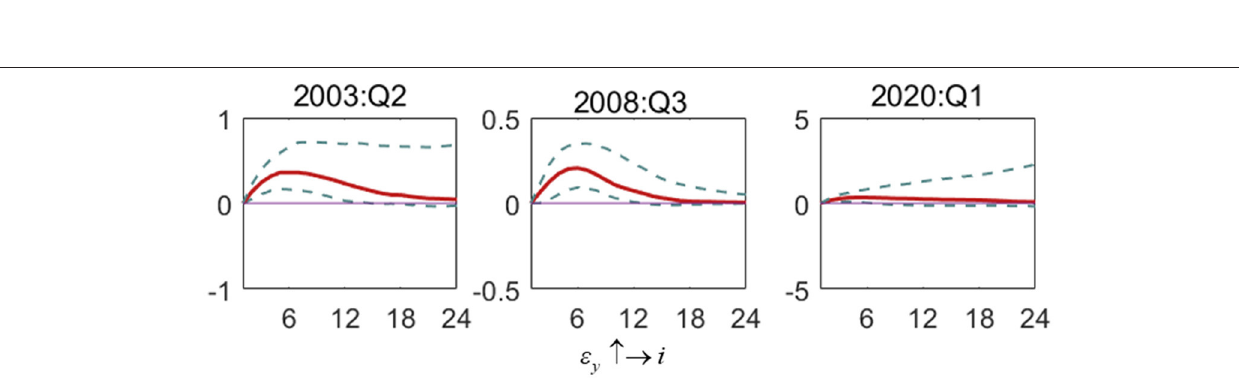
FIGURE 7 | The impulse response of the interest rate to output gap shock in special periods. Each subfigure demonstrates three special periods, including the SARS outbreak period (2003:Q2), the global financial crisis period (2008:Q3) and the COVID-19 outbreak period (2020:Q1 ). One period in the figure denotes one